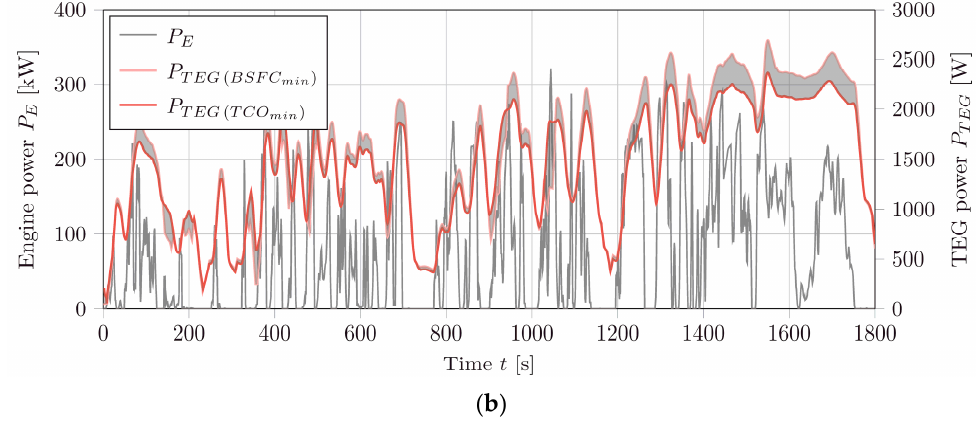
Figure 11. Results of dynamic TEG optimization with different objectives in WHVC driving cycle.